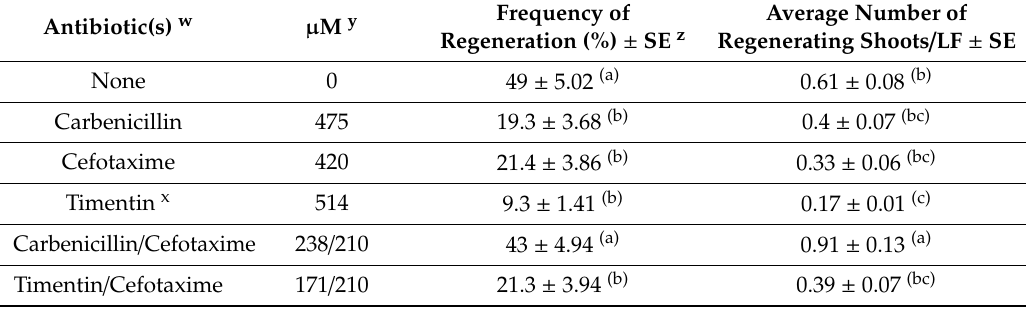
Table 2. Effect of antibiotics on the regeneration efficiency from Hansen 536 leaf (LF) explants Table 2. E ff ect of antibiotics on the regeneration e ffi ciency from Hansen 536 leaf (LF) explants cultured cultured for five weeks on WPM 11 medium. for five weeks on WPM 11 medium.